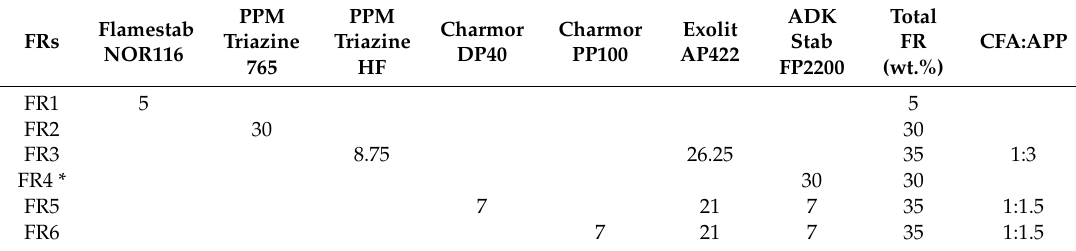
Table 1. Composition of FR formulations in wt.% for polyethylene grades. All formulations contained 0.05 wt.% calcium